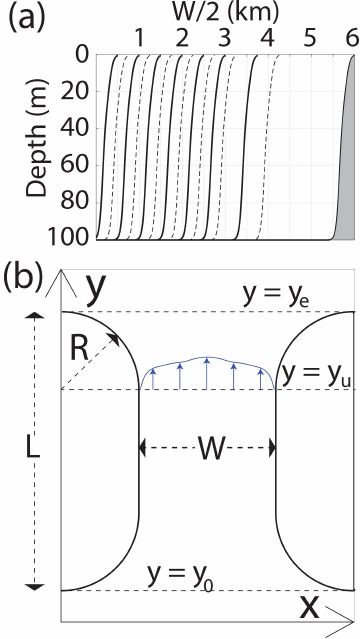
Figure 3. (a) Vertical cross section of bottom topography from the strait center to the eastern coastline for the different strait widths. The solid and dashed lines are used to more easily differentiate be- tween the different strait widths. (b) The coordinate system of the strait